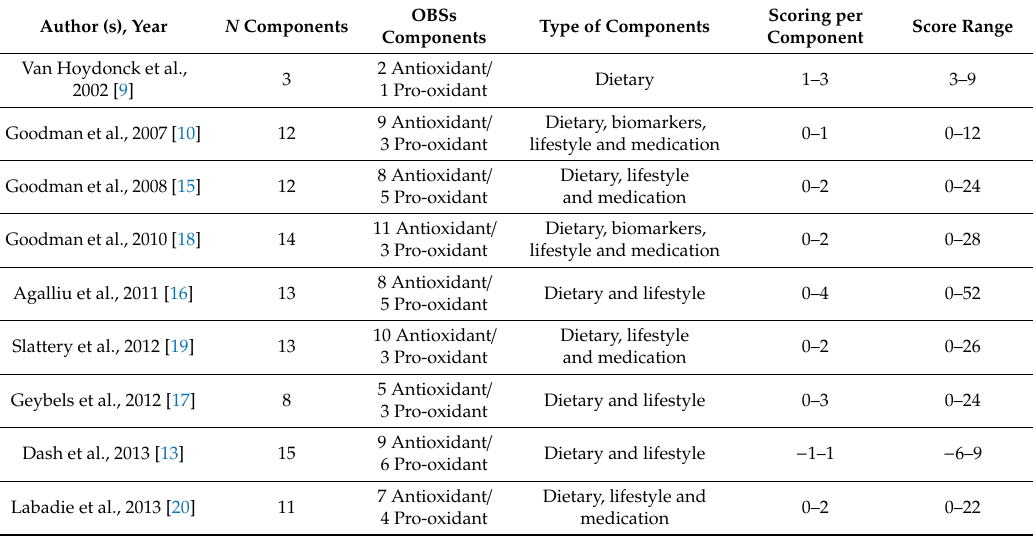
Table 1. Description of the a priori Oxidative Balance Scores (OBSs), components, and scoring